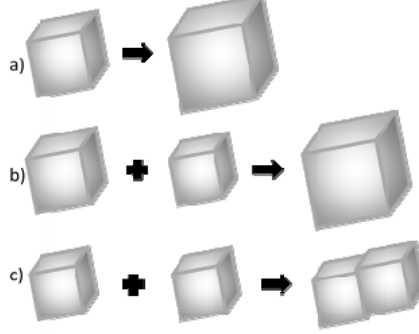
Figure 10. Mechanisms of calcium carbonate crystal growth: ( a ) attachment of new ions to the existing crystallite; ( b ) Ostwald’s recrystallization; and ( c ) coalescence.